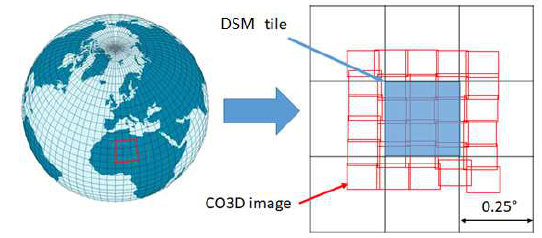
Figure 2. GLOBAL-DEM tiles production strategy (example) So each instance of the DSM production pipeline has to process numerous stereo acquisitions to generate a DSM tile (all images that intersect the tile and margins).